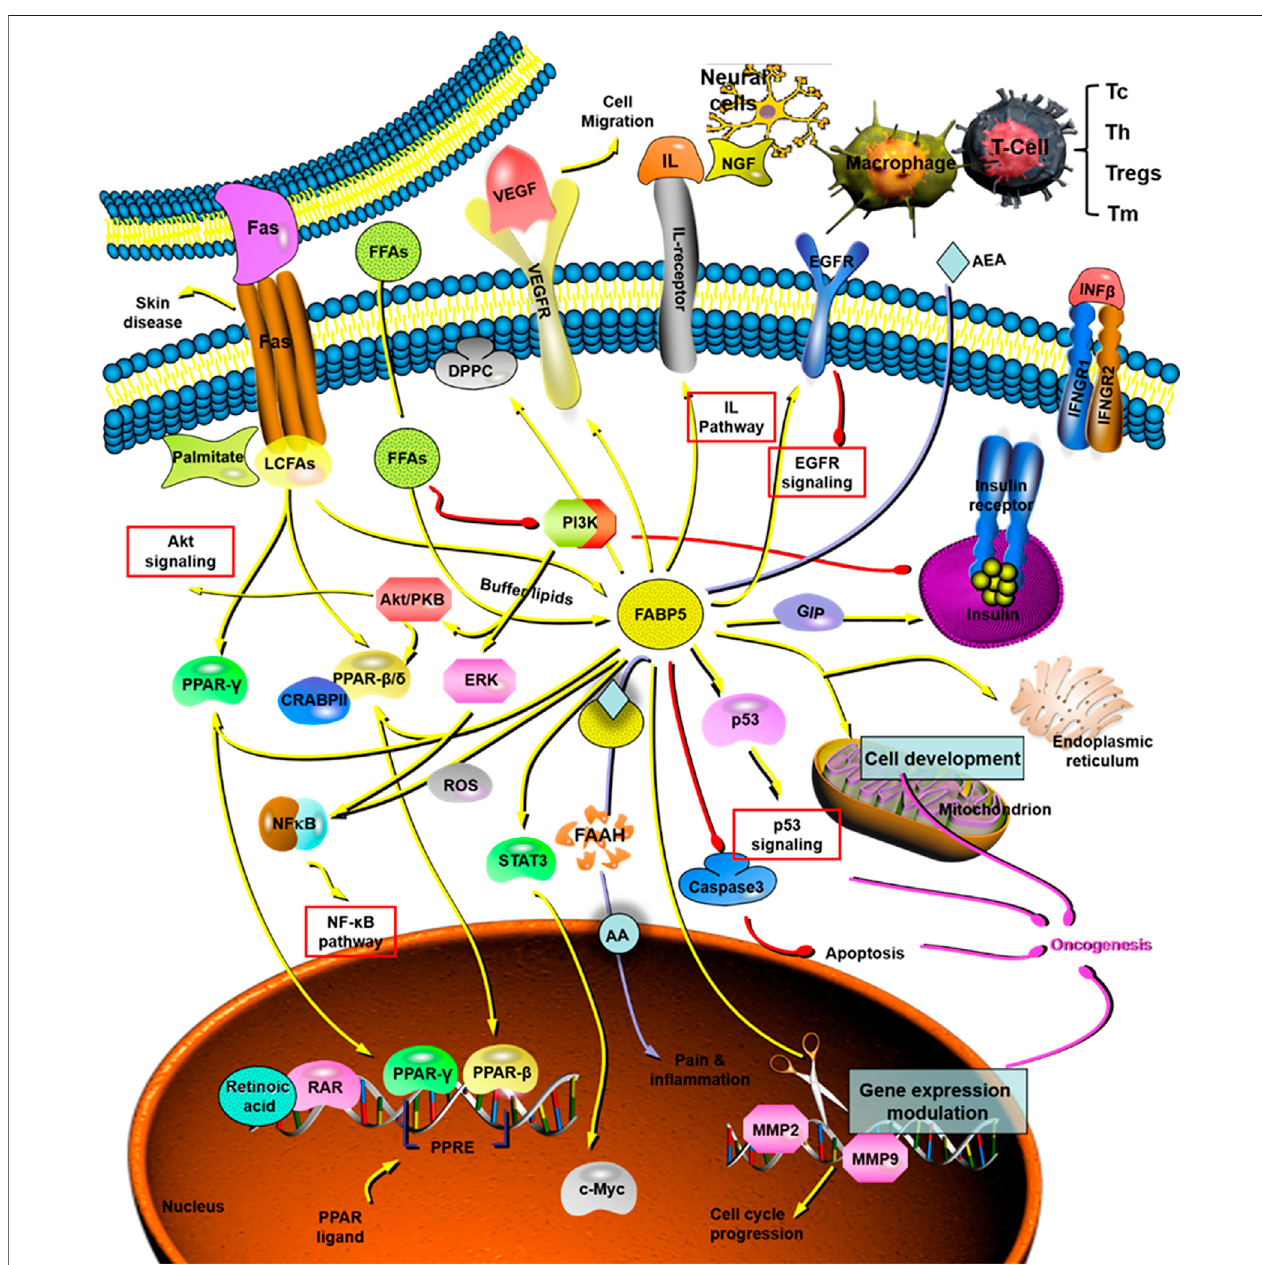
FIGURE 7 | The role and mechanism of FABP5 in tumorigenesis and cancer development. FABP5 plays critical roles in cancer initiation and progression through the AKT pathway, NF- κ B pathway, IL pathway, EGFR pathway, p53 pathway, and so on. AA: arachidonic acid; AEA: endocannabinoid anandamide; CRABP: cytosolic retinoic acid-binding protein; DPPC: dipalmitoyl phosphatidyl choline; EGFR: epidermal growth factor receptors; ERK: extracellular regulated protein kinases. FAAH: fatty acid amide hydrolase; FAS: fatty acids; FFA: free fatty acids; FABP5: fatty acid binding protein 5; GIP: glucose-dependent insulinotropic polypeptide; IFN: interferon; IL: interleukin; LCFAS: long-chain fatty acids; MMP: matrix metalloproteinase; NF- κ B: nuclear factor-kappa B; NGF: nerve growth factor; PI3K: phophatidylinositol-3-kinase; PPAR: peroxisome proliferator-activated receptor; PPRE: proliferator-activated response element; RAR: retinoic acid receptor; ROS: reactiveoxygenspecies; STAT:signaltransducerandactivatoroftranscription;Tc:cytotoxicTcell,CD8 + Tcell;Th:helperTcell,CD4 + Tcell;Treg:regulatoryTcell;Tm: memory T